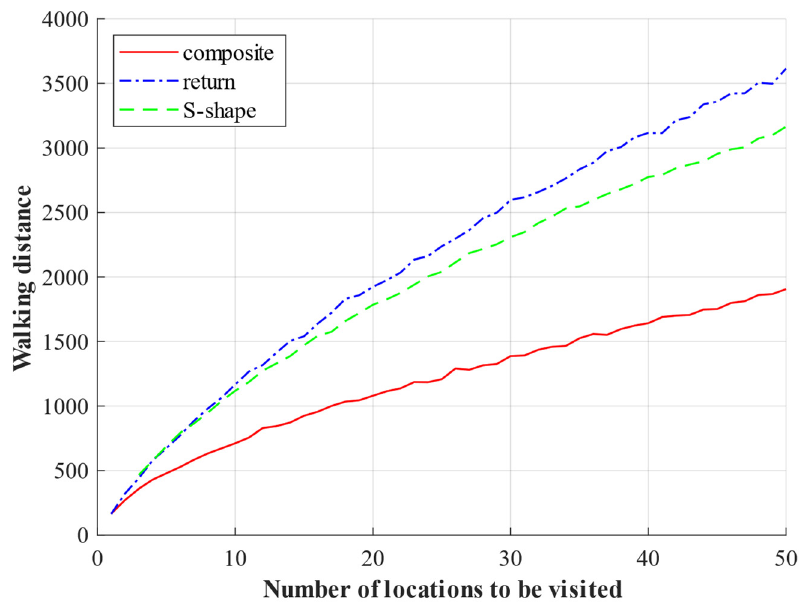
Figure 9. Comparison of results of different routing strategies in the leaf layout warehouse.